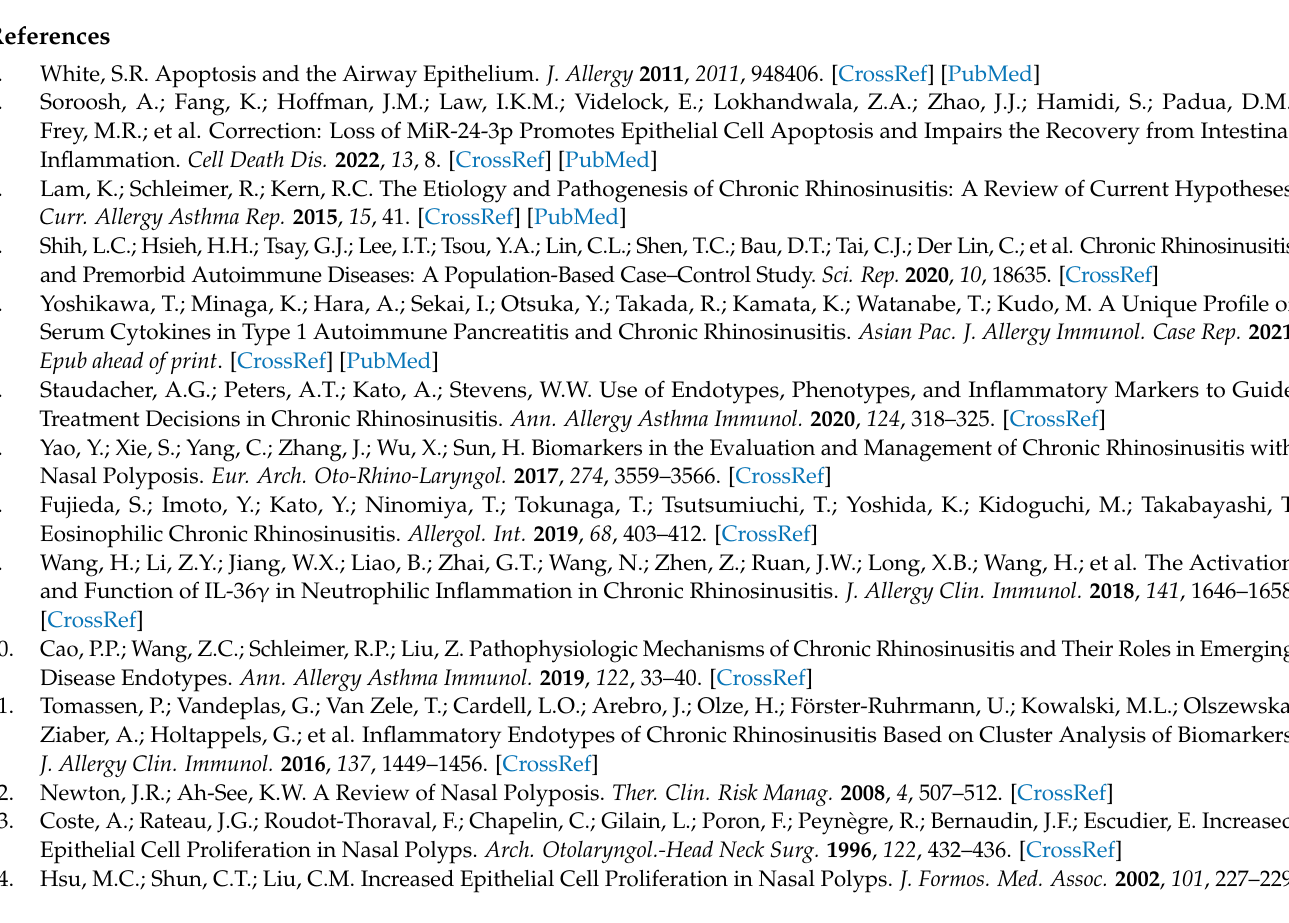
RT-qPCR analysis. Table S3: Data used for comparative statistical analysis. Quantification results are present as mean values ± standard deviation